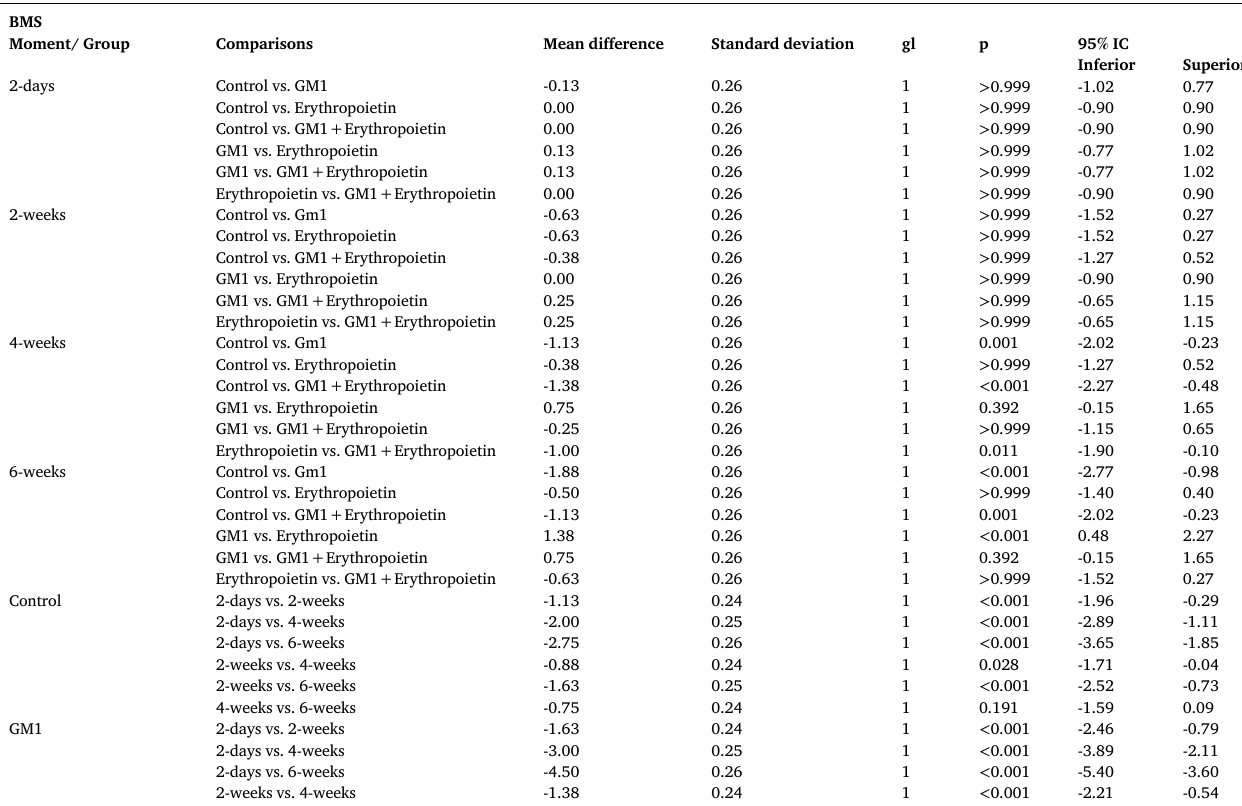
Table 3 Result of multiple BMS scale comparisons per group and assessment time point. BMS Moment/